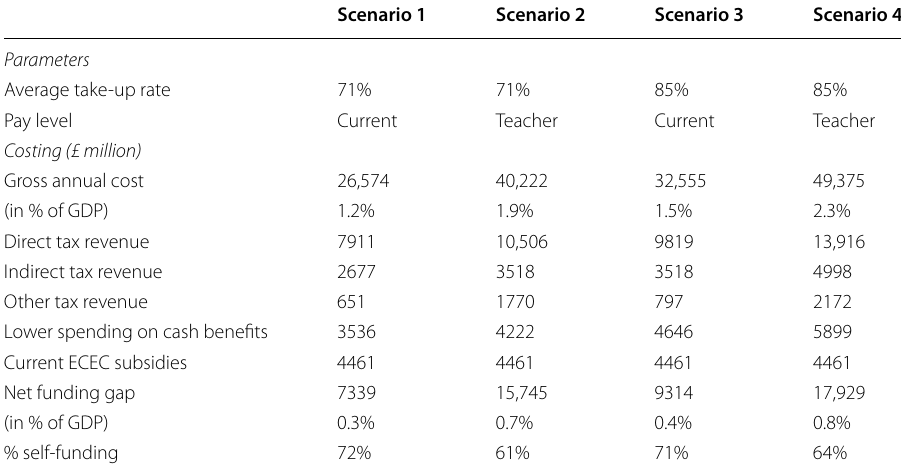
Source: own calculations using UKMOD microsimulation tool, ONS (2020) and OECD (2020). ‘Teacher’ pay levels signifies the pay scale of primary school teachers of equivalent qualification. ‘Current’ pay levels reflect wage rates in current commercial facilities for equivalent qualification. Current ECEC subsidies include free childcare entitlement for eligible 2‑to‑4 year‑olds and tax relief on childcare expenses but excludes spending on tax credits as part of the means‑tested benefits since these are simulated in UKMOD (part of ‘lower spending on cash